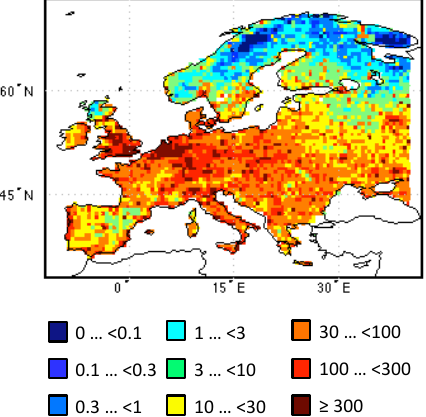
Figure A1. Current (2010) population density (inhabitantskm − 2 ) in Europe by ranges considered in the analysis. Derived from grid- ded observed 2005 values extrapolated to 2010 using SSP2.